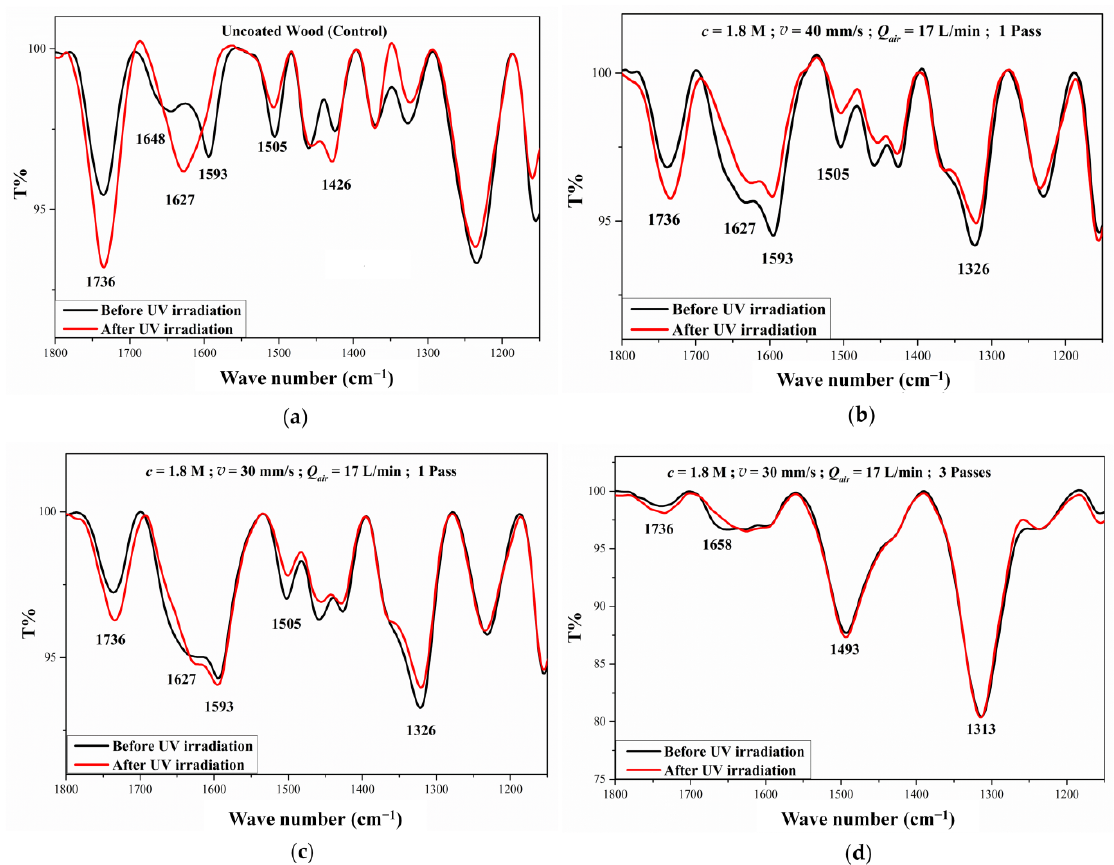
Figure 12. FTIR–ATR spectra, in the region from 1800 to 1200 cm − 1 , of the ZnO-coated and uncoated wood samples, before and after UV irradiation: ( a ) uncoated wood; ( b ) coated at v = 40 mm/s, Q air = 17 L/min, 1 pass; ( c ) coated at v = 30 mm/s, Q air = 17 L/min, 1 pass; ( d ) coated at v = 30 mm/s, Q air = 17 L/min, 3 passes.